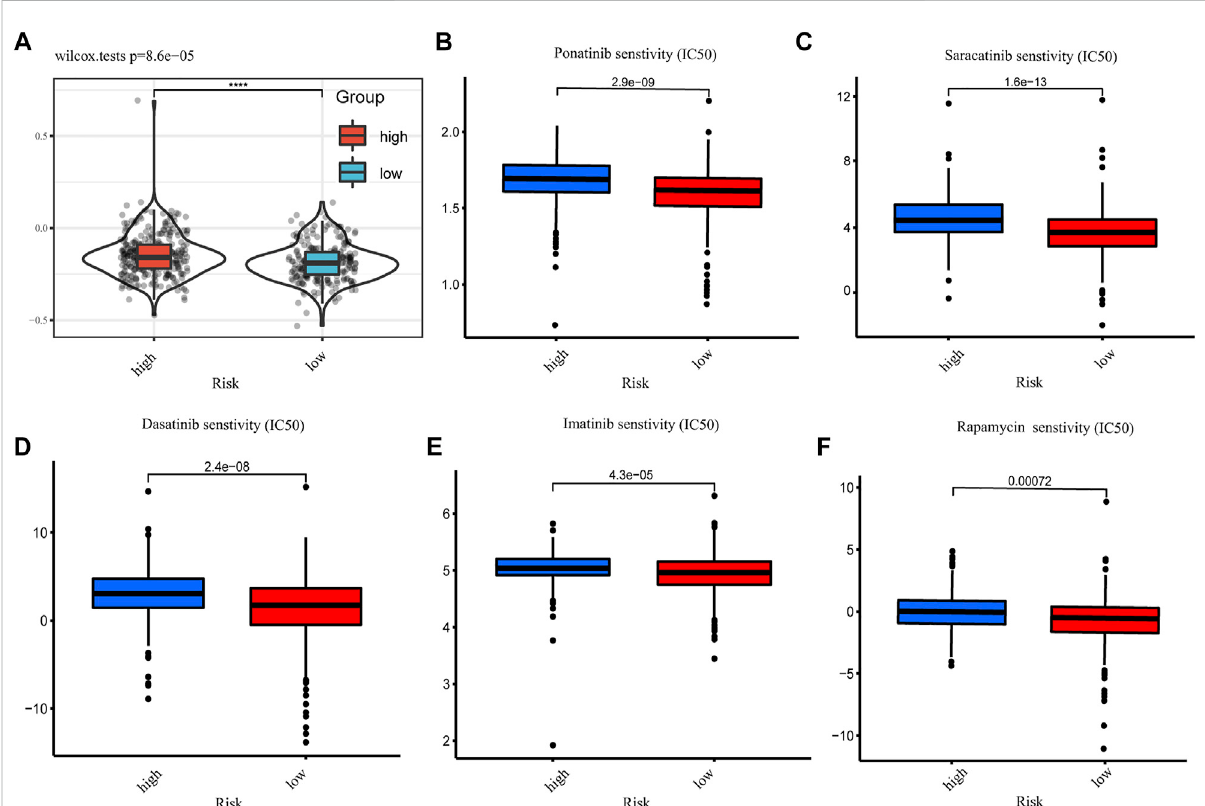
FIGURE 6 Drug susceptibility prediction. (A) Tumor immune dysfunction and exclusion (TIDE) scores between CRG-Score groups (* p < 0.05, ** p < 0.01, *** p < 0.001). (B) IC50valuesofPonatinibbetweenCRG-Scoregroups. (C) IC50valuesofSaracatinibbetweenCRG-Scoregroups. (D) IC50valuesof Dasatinib between CRG-Score groups. (E) IC50 values of Imatinib between CRG-Score groups. (F) IC50 values of Rapamycin between CRG-Score